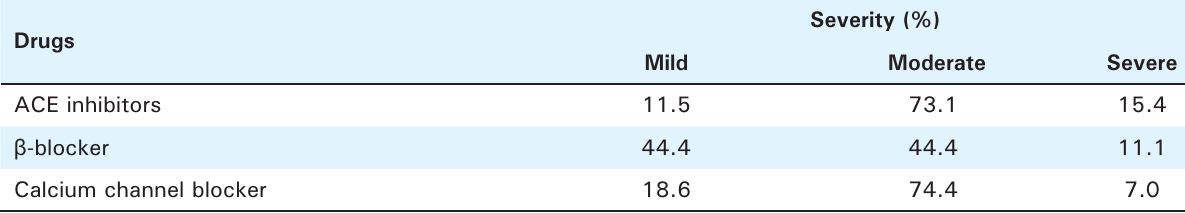
Table 1. Severity of gingival enlargement in patients taking antihypertensive Drugs